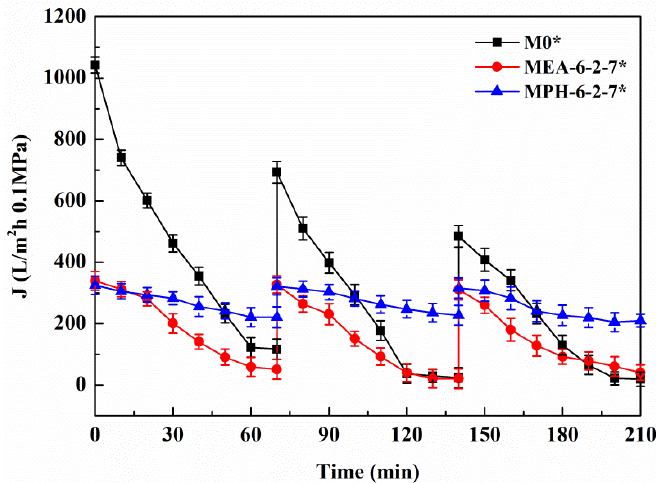
Figure 8. Permeate flux decline behavior of various membranes during the cyclic filtration of BSA solution with 100 mmol/L